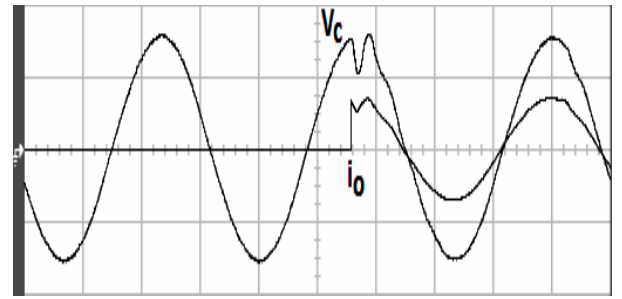
Figure 8. Experimental waveforms under step loading from no load to full load with the classical